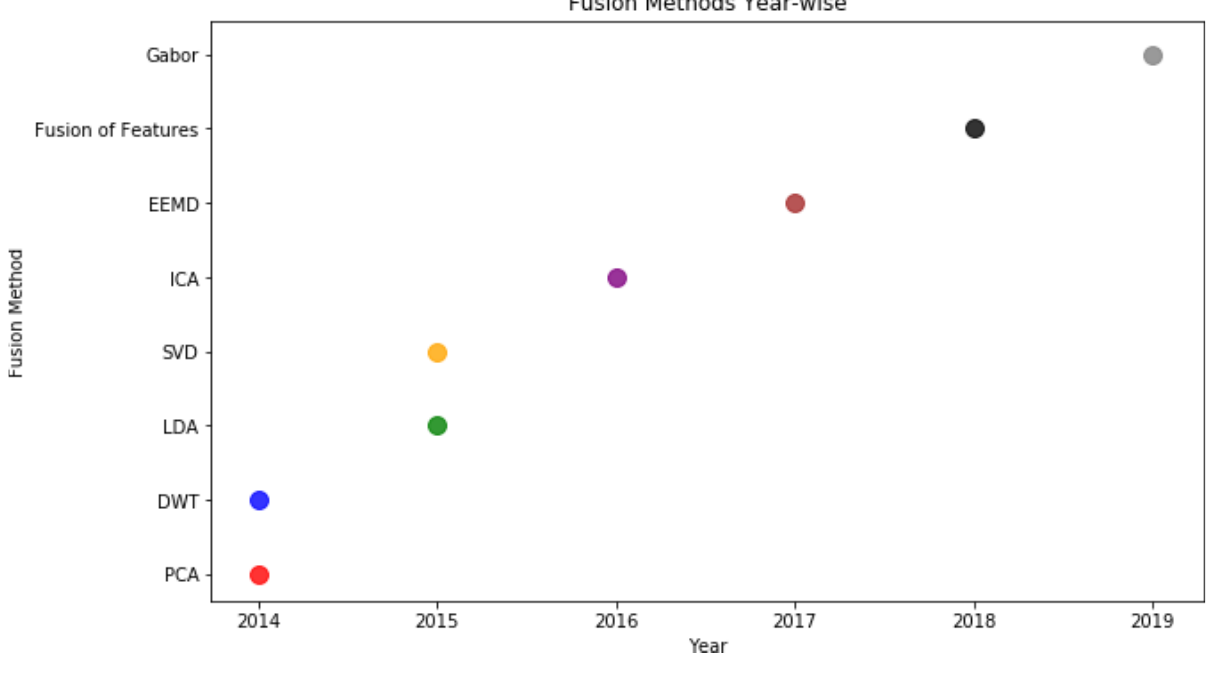
Figure 8. Fusion of Features Year Wise. Table 6. Fusion and Registration methods for AD and Subtypes